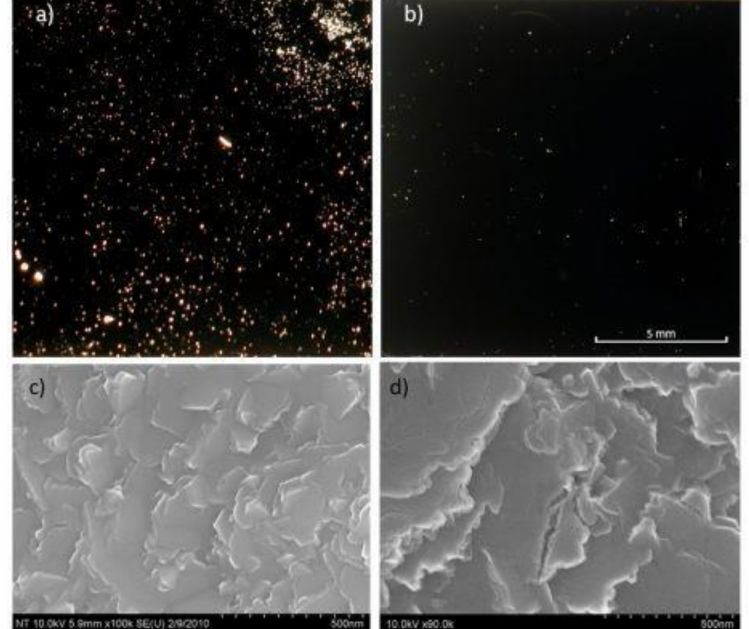
Figure 3. Optical microscope image of defects (pinholes) on ( a ) evaporated and ( b ) sputtered Ti metal on FTO glass, SEM surface morphology of ( c ) evaporated and ( d ) sputtered Ti metal on FTO glass. Reprinted with the permission from reference [33].